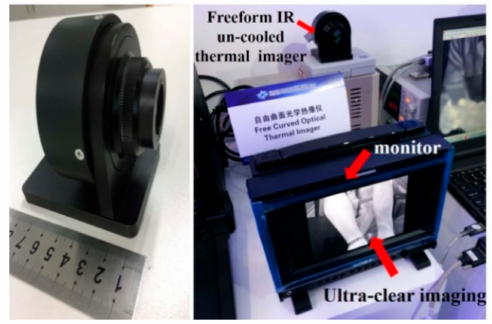
Figure 13. Exhibition picture of the freeform IR un-cooled thermal